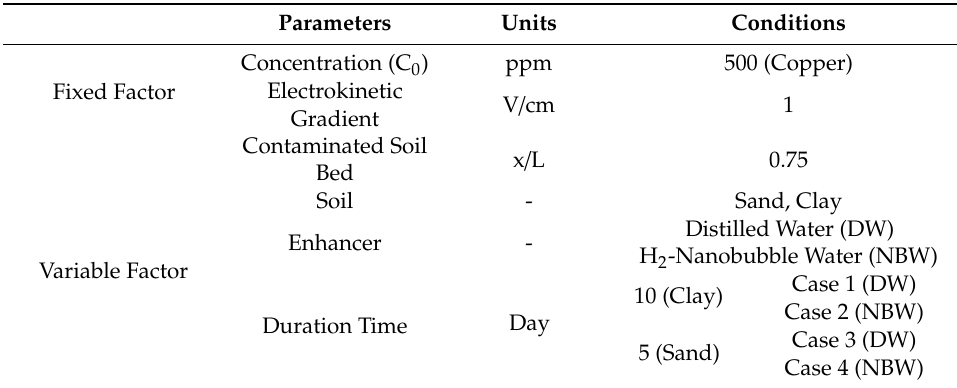
Figure 4. ( a ) Side view. ( b ) Floor plan. Diagram of the Electrokinetic system. Table 4. Electrokinetic test conditions.